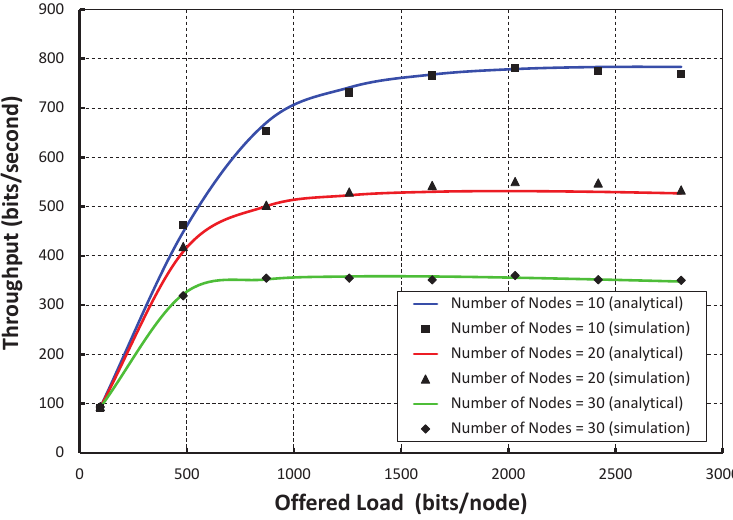
Figure 7. Validation of throughput for different offered loads.